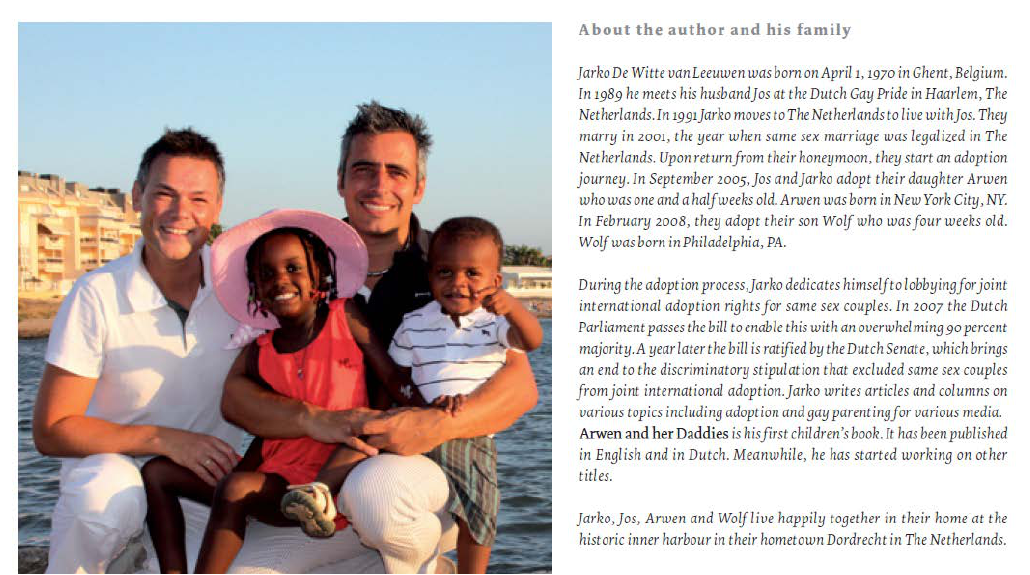
Figure 16. Transatlantic adoption across the color line. Like Nehemiah in Aldrich’s book, Arwen drafts two foundational moments in her queer genealogies. The first lies in the precarious situation of a black mother who is unable to take care of her child. De Witte van Leeuwen ventriloquizes and explains the process of adoption for other children in the voice of a fellow adoptee: “First I was in my mommy’s tummy, She lived in a city far away: New York. But she couldn’t take care of me. […] she went to people who could help her. These people work at an adoption agency.” A second foundational moment in her family history overwrites the former in terms of significance and relocates familial beginnings from “tummy” into De Witte van Leeuwen’s “arms.” Geographic distances and racial differences between Arwen and her designated parents are bridged by textually and visually foregrounding this moment in terms of effort, affection, and care. Amid the symbolism of flowers, another queer couple affirms itself as family life to the implied viewer’s gaze and emphasizes nuclear-domestic commitment to ensure their recognition as a viable family constellation: “A real family,” “Right from the start my daddies took good care of me. They bathed me, and they fed me my bottle. Then we flew home together.” I would argue that distances and differences in the making of this family are also sought to be painted over through a conspicuous coloring of the parents, where Jarko’s partner appears with a skin complexion near that of Arwen’s. From the angle of a symptomatic reading, this mode of representation seems to echo familial norms of physical resemblance. In convergence with reciprocal affection, the skin colors of these family members are radically approximated to underline the semantics of unity and continuity, “a real family.” My point is neither to criticize gay desires for familial recognition nor to dismiss picture books such as Arwen & Her Daddies . These primers are carrying out important interventions that enable children like Arwen and fathers like De Witte van Leeuwen to see themselves reflected in an everyday act of reading to and with one another. More than that, potentially, such books might also find their way onto the bookshelves of children with heterosexual parents to widen the focus of an established,